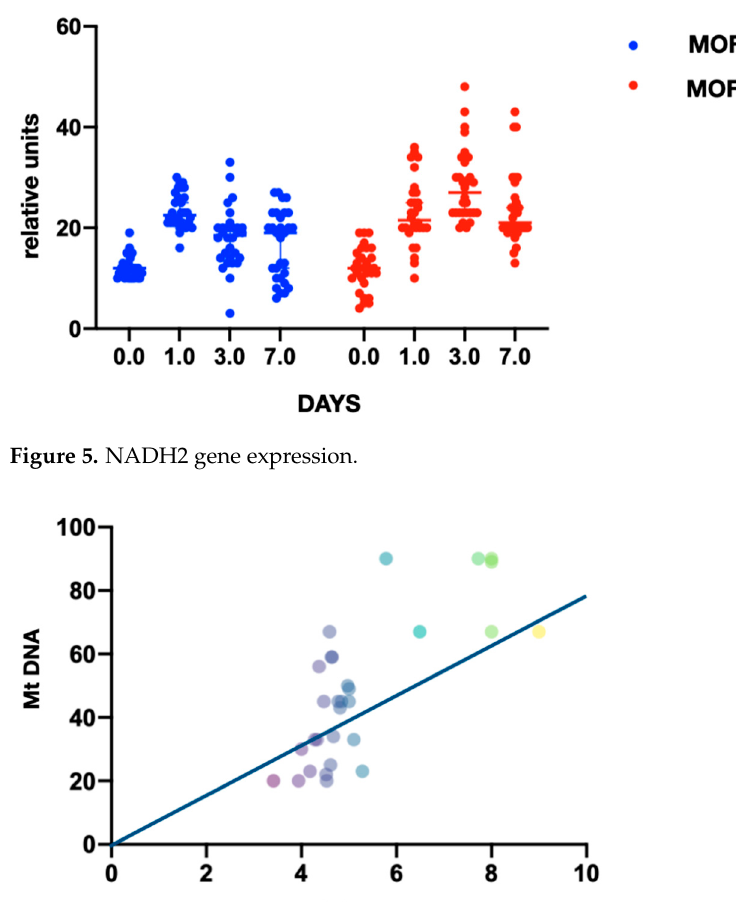
in serum (AUC = 0.605) can be a predictor of the development of MOF (Figure 7).